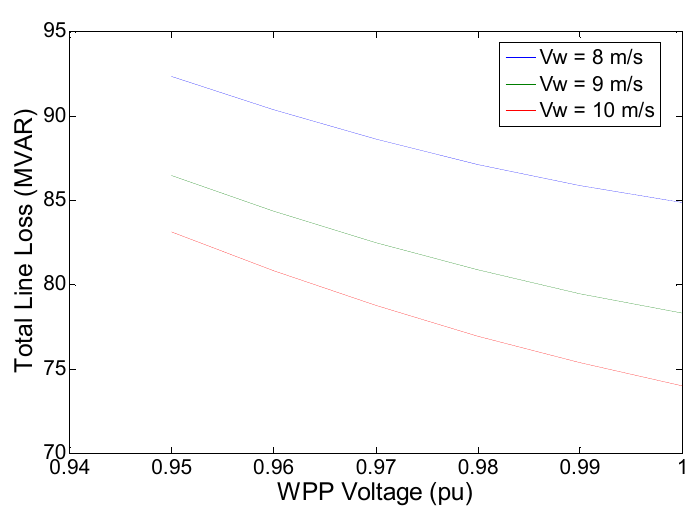
Figure 17. Variation of line active power loss.